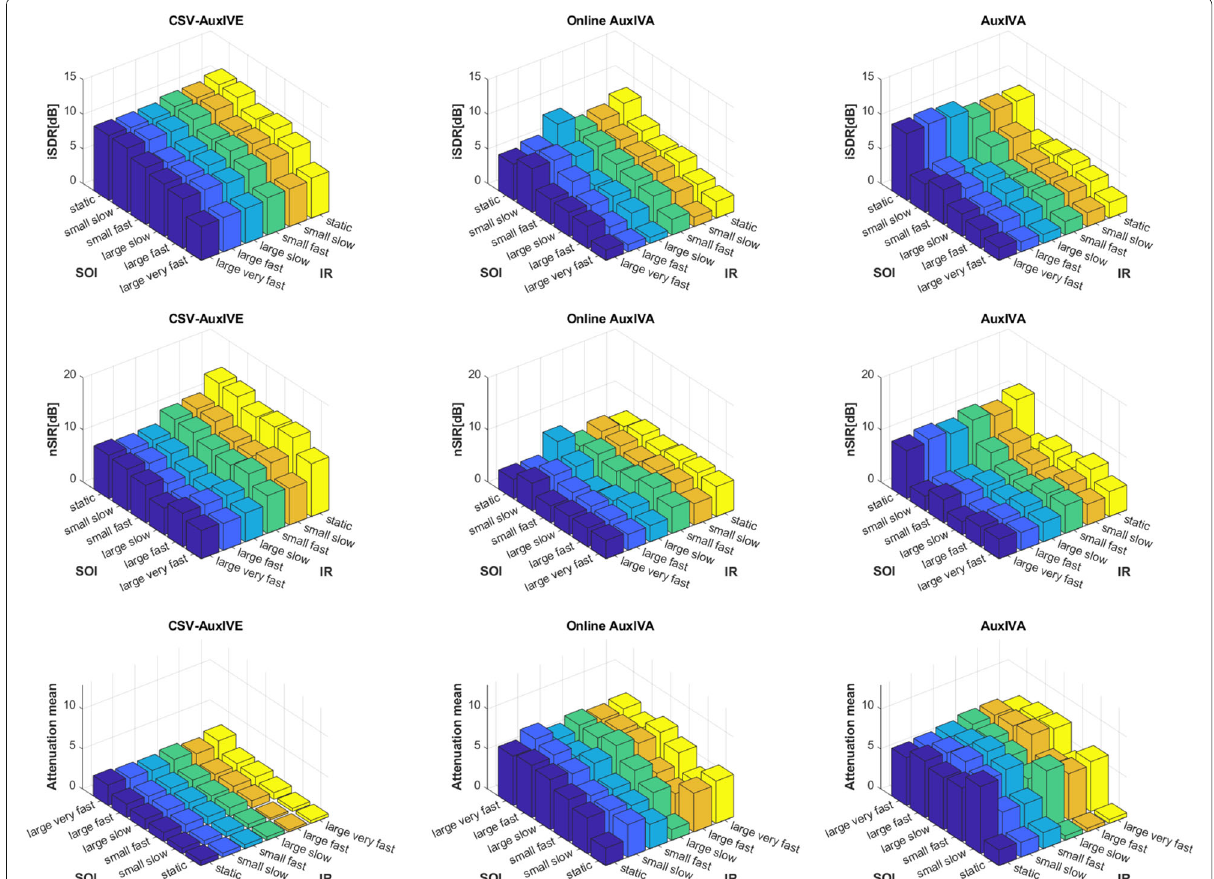
Fig. 5 The accuracy of the blind extraction of the SOI in terms of iSDR, nSIR, and Attenuation in the experiment in Section 4.2. The indices on the SOI and IR axes correspond with Table 3. Please note that, for better readability, the axes of the plots showing the Attenuation are